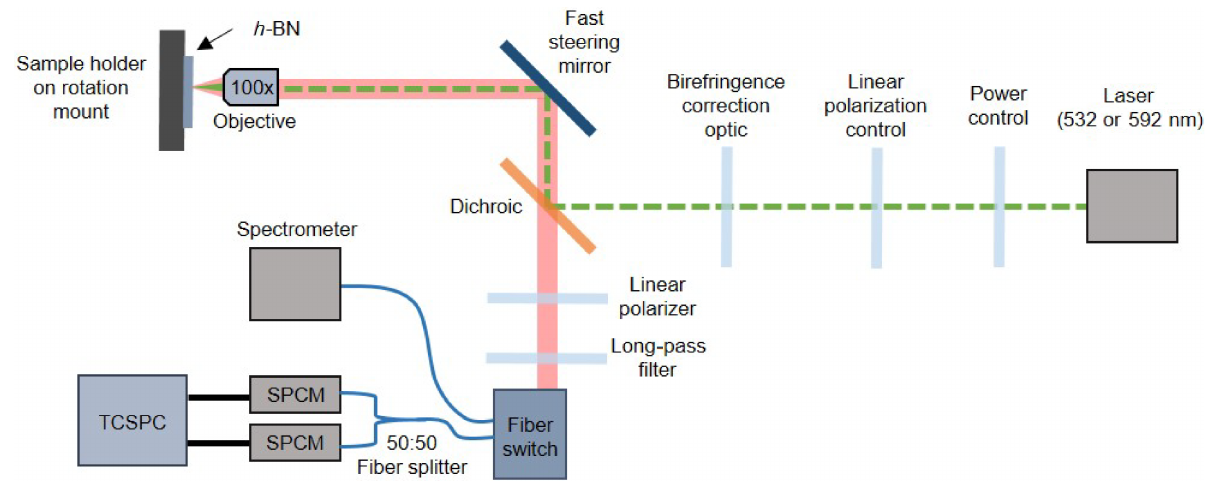
FIG. 7. Experimental setup. A simplified version of the room-temperature optical setup showing the essential optical and electronic components used to probe the QEs in h -BN. The green dashed line represents the 532 nm (green) excitation path that can be switched to 592 nm (orange)